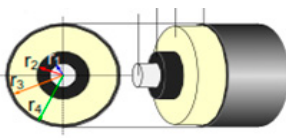
Figure 4. Schematic representation of DC miniature cable used for testing: Conductor radius r 1 = 0.65 mm; Inner semicon radius r 2 = r i =1.45 mm; Insulation radius r 3 = r o = 2.95 mm; Outer semicon radius r 4 = 3.65 mm.